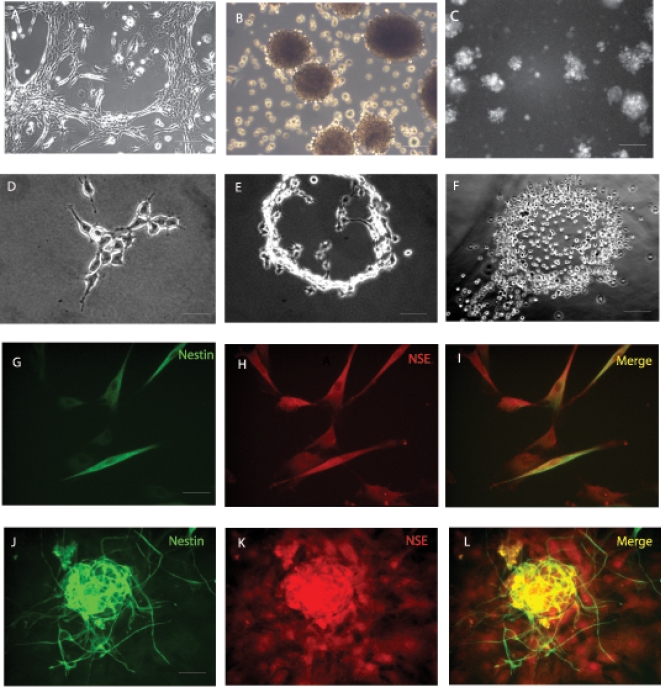
Proliferation of mouse adipose-derived adult stromal (ADAS) cells in media formulations optimized for neural stem cells.Cells grow as adherent cultures (A) and upon reaching high confluence they form neurosphere-like clusters (B) in a serum-free media formulation (Media A) which are indistinguishable from neurospheres derived from the subventricular zone in the hippocampus of young adult mice (C); Single-cell derived colonies growing in NeuroCult (Media B) (D) expand to form ring-like structures (E, F); Neural stem cell marker expression in adherent mouse ADAS cells (G–I) and neurospheres (J–L) proliferating in Media A. NSE, Neuron Specific Enolase. Scale bar in A, B, C and F = 220 um; scale bar in D, E G–I = 55 um; scale bar in J–L = 110 um.